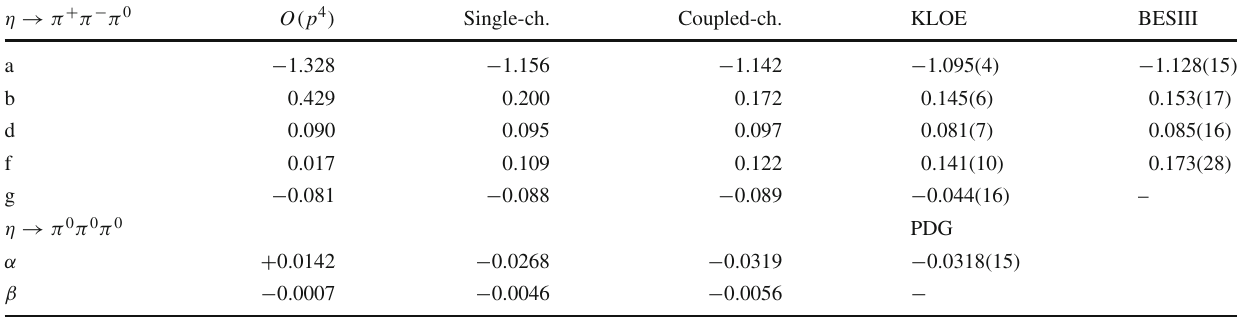
Table 2 Results for the Dalitz plot parameters of the charged and neu- tral η → 3 π decays based on the NLO chiral amplitude (in the form given in Appendix A with L 3 = − 3 . 82 · 10 − 3 ) and its dispersive extrap-